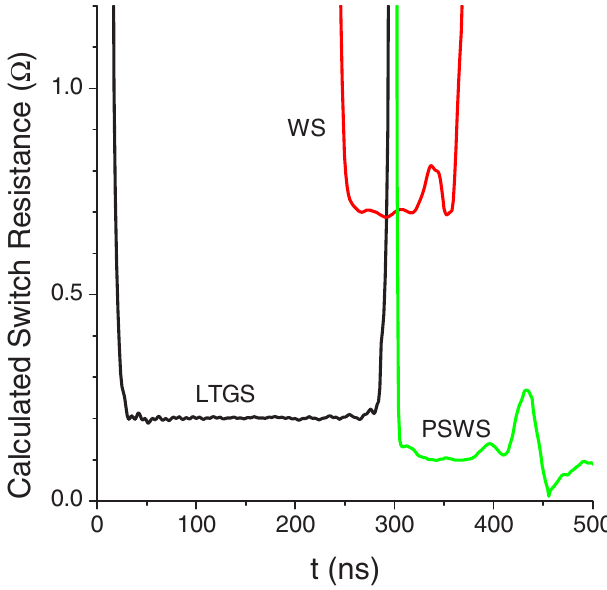
FIG. 5. (Color) Individual switch-resistance time histories in- ferred from the simulation.